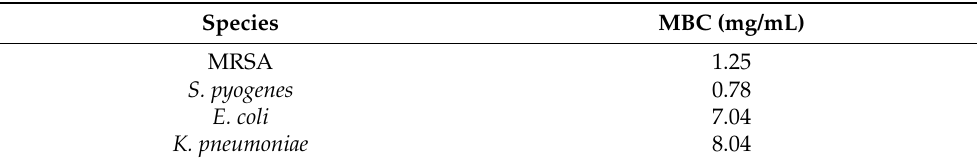
Table 2. Testing GS-2 against clinically isolated pathogens using CLSI M26-A guidelines for 24 h of exposure. n =